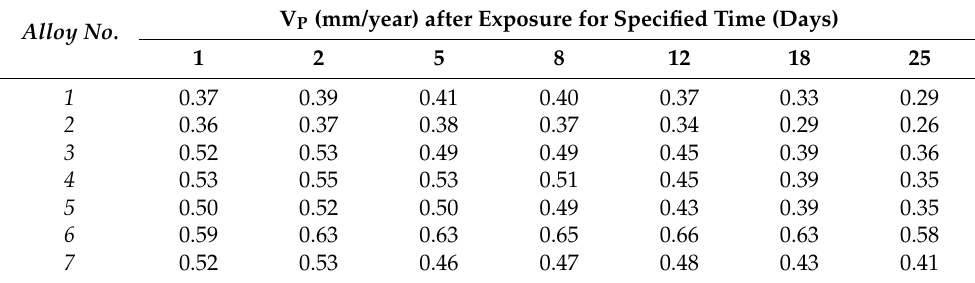
Table 4. Corrosion rate V P after exposure of specimens in 3% solution of NaCl. Alloy